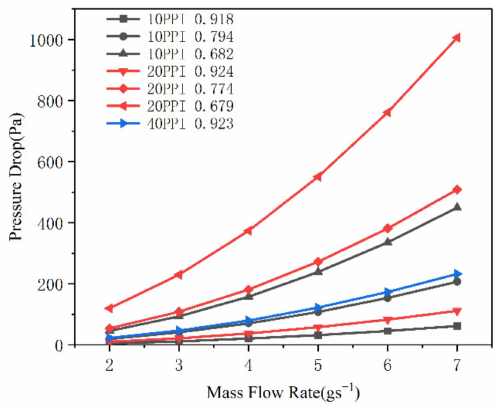
Figure 4. Pressure drop versus mass flow rate with different parameters of AFHS.